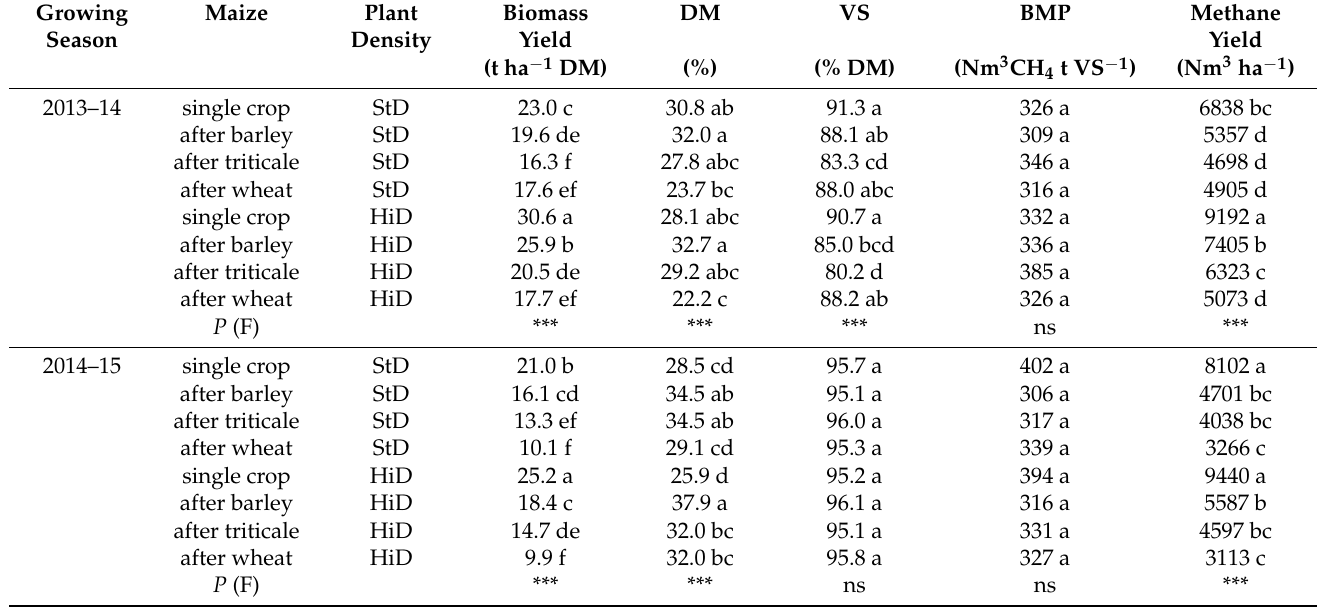
Table 6. Biomass yield, biochemical methane potential (BMP), and methane yield per hectare of the maize crops for different sowing times 1 and plant densities 2